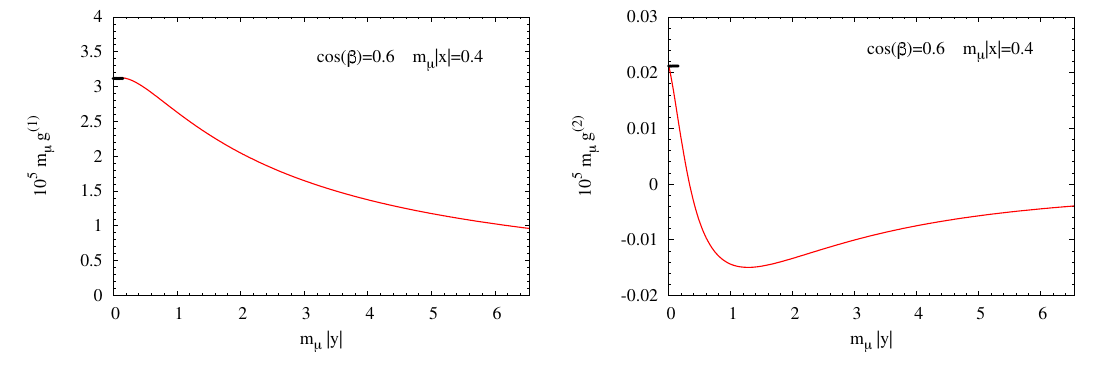
Figure 5 . The vector weight functions ¯ g (1) and ¯ g (2) appearing in the QED kernel for given values of | x | and ˆ c β ≡ ˆ x · ˆ y , the muon mass being denoted by m µ . The leading term of the Taylor expansion around the origin (O ( | y | 0 ) ) is indicated as a short horizontal line. 10 5 × weight fct.